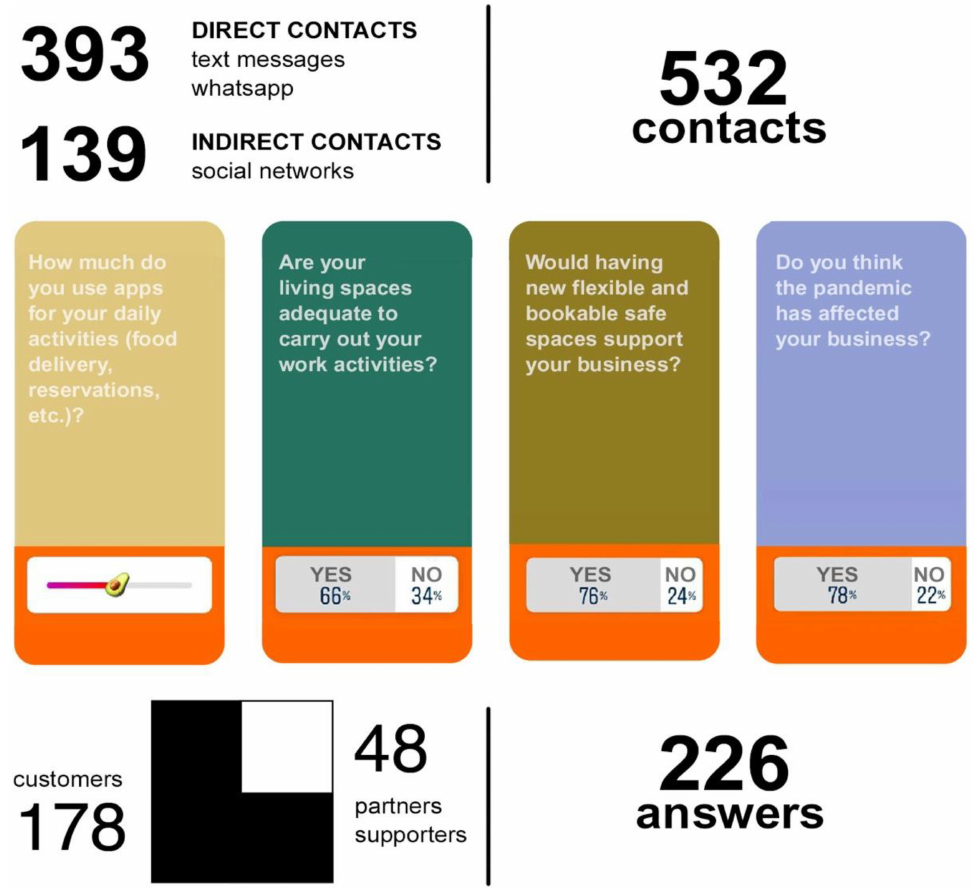
Figure 6. An overview of the contacts and answers in the demand